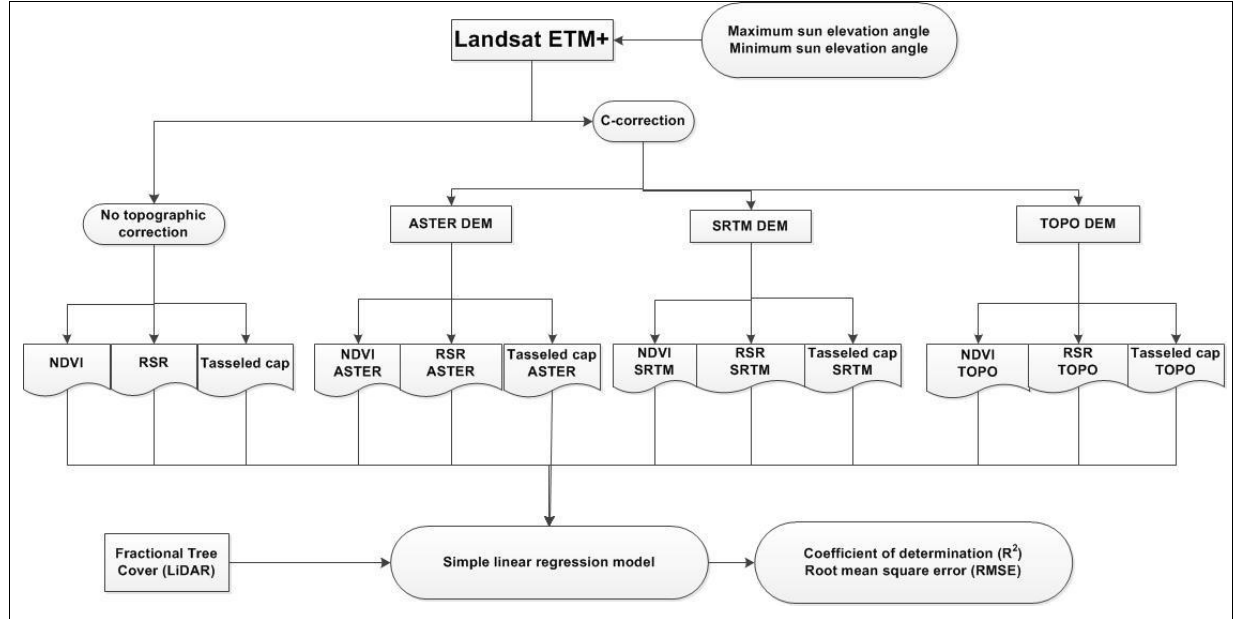
Figure 2. Overview of the methodology